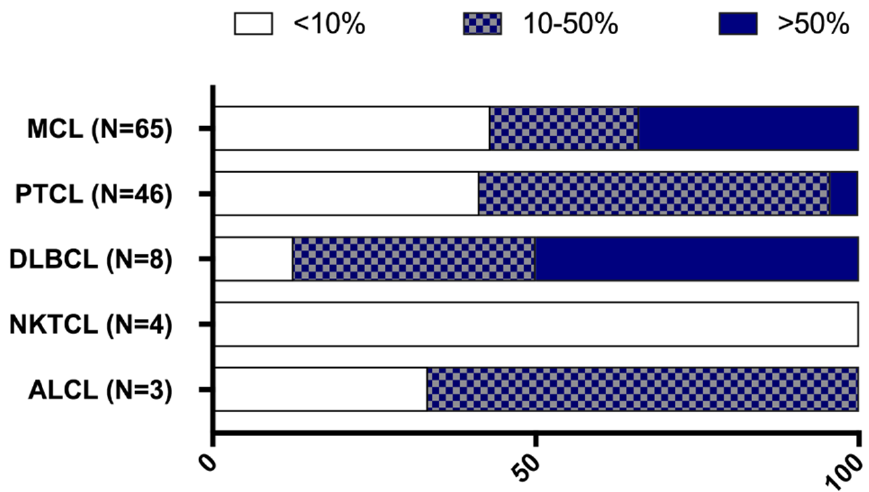
Figure 4. Proportion of CD70 staining among various lymphoma subsets. CD70 staining was categorised in three different groups: CD70 positive tumour cells ranging from 0 to 10% (white bars); between 10% to 50% (patterned bars); and expression levels above 50% (blue bars). ALCL, anaplastic large cell lymphoma; DLBCL, diffuse large B cell lymphoma; MCL, mantle cell lymphoma; NKTCL, NK/T cell lymphoma; PTCL, peripheral T-cell lymphoma. Table 1. CD70 and CD27 expression analysis in mantle cell lymphoma (MCL) samples.